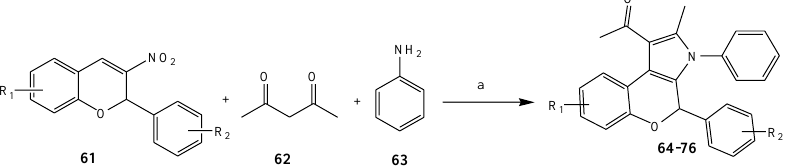
Scheme 5. Synthesis of bis-pyrrole derivatives.